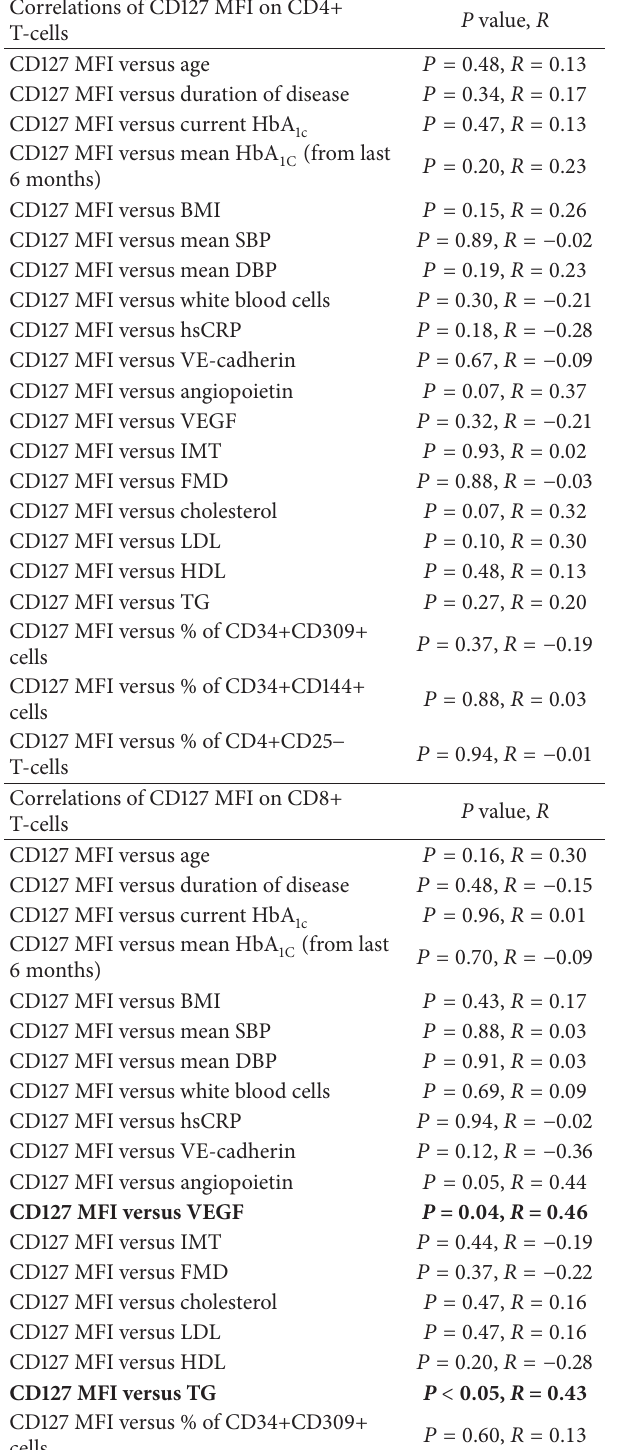
Table 3: Comparison of correlations among CD127 expression on CD4+ (first part of the table) and CD8+ (middle part of the table) T-cells and frequencies of CD4+CD25+CD127 − T-cells (last part of the table) and metabolic, inflammatory, and vascular/endothelial parameters in children with long-lasting